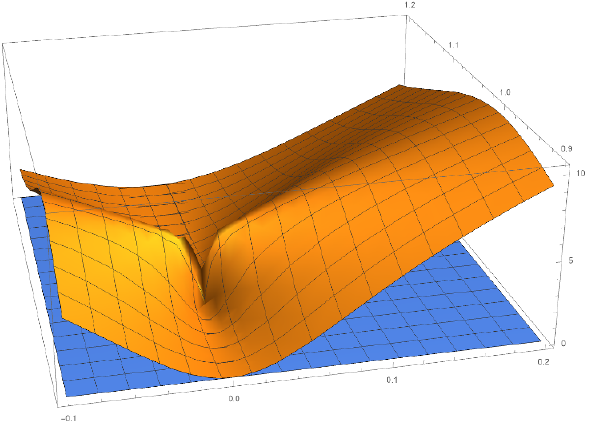
Figure 1 . The two terms of the r.h.s. of eq. (3.48) are represented as two di(cid:11)erent surfaces for the case of two centers with ~x 1 = (0 ; 0 ; 0) ; ~x 2 = (0 ; 0 ; 1) ; h = 1 ; p 1 = 2 ; p 2 = 3 ; (cid:21) = 1 ; ( s (cid:11) ) = (3 ; 2) ; g = 1 ; ( (cid:17) (cid:11) ) = (1 ; 2). The blue surface always lays below the yellow surface, whence g ’’ remains (cid:12)nite and